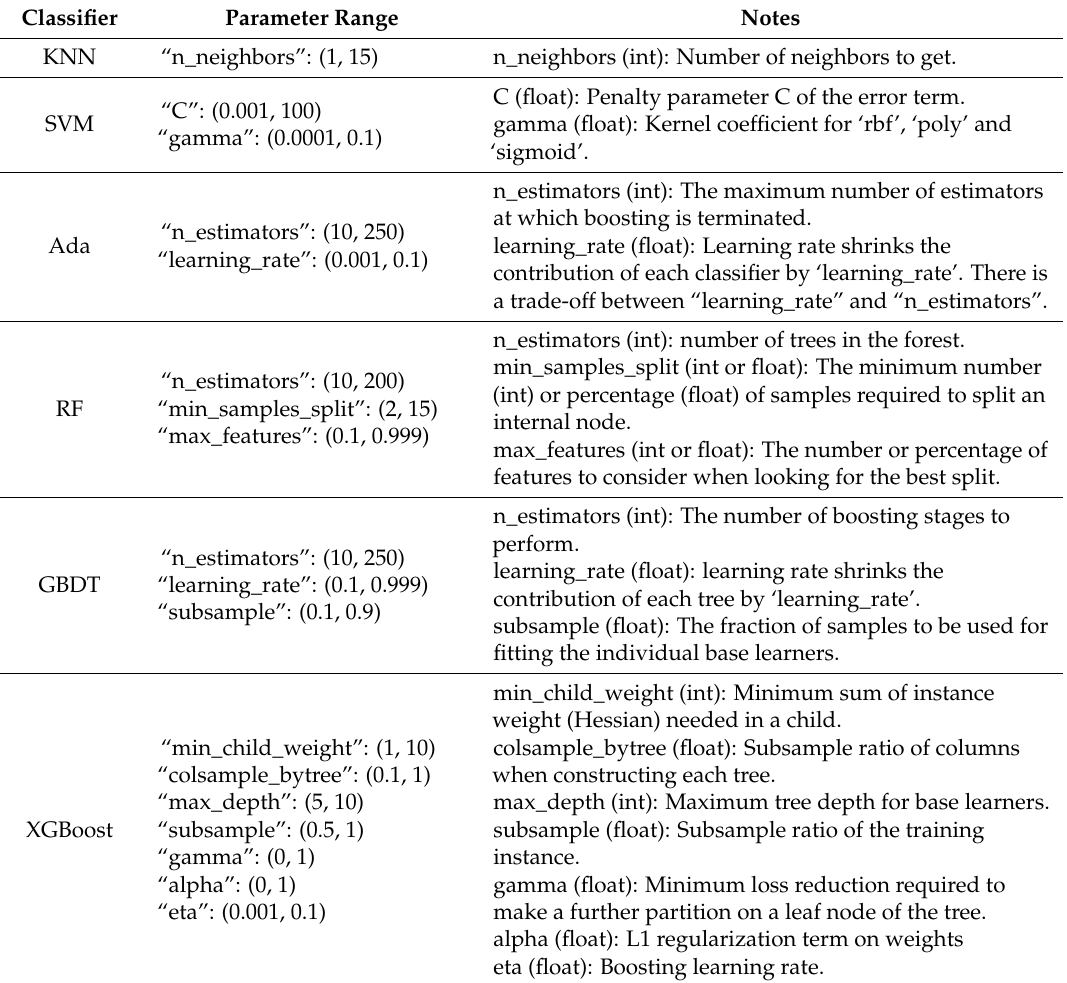
Table 3. Parameter Ranges for Parameter